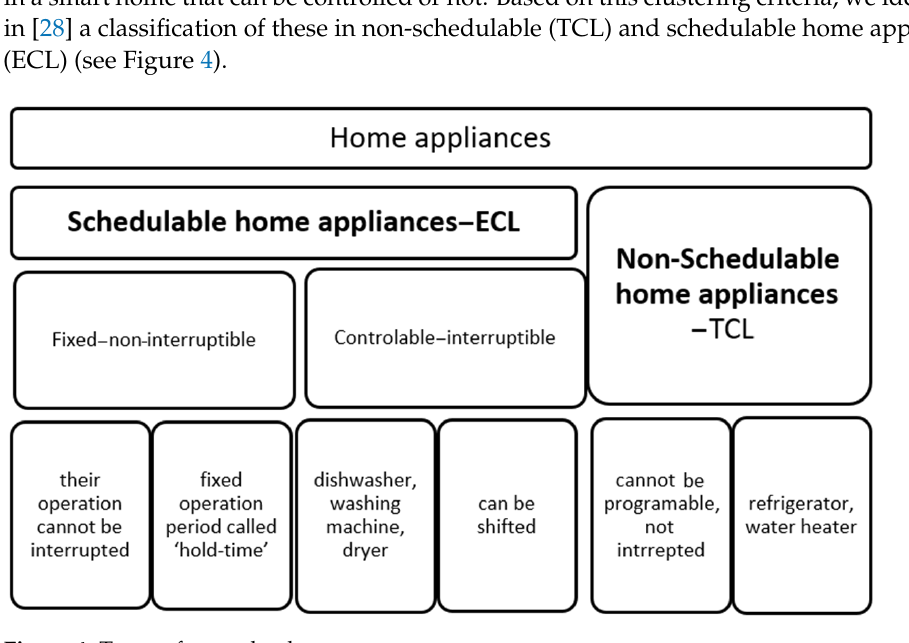
Figure 4. Types of smart